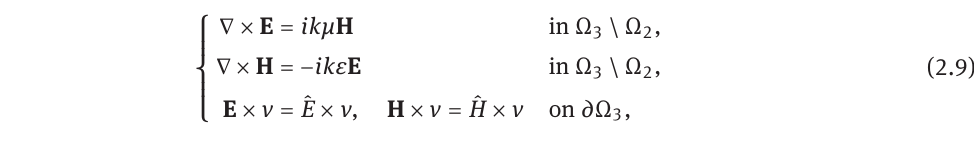
\ ̄ Ω \ ̄ Ω ( x ) = x on ∂ Ω 1 to Ω 3 2 such that F